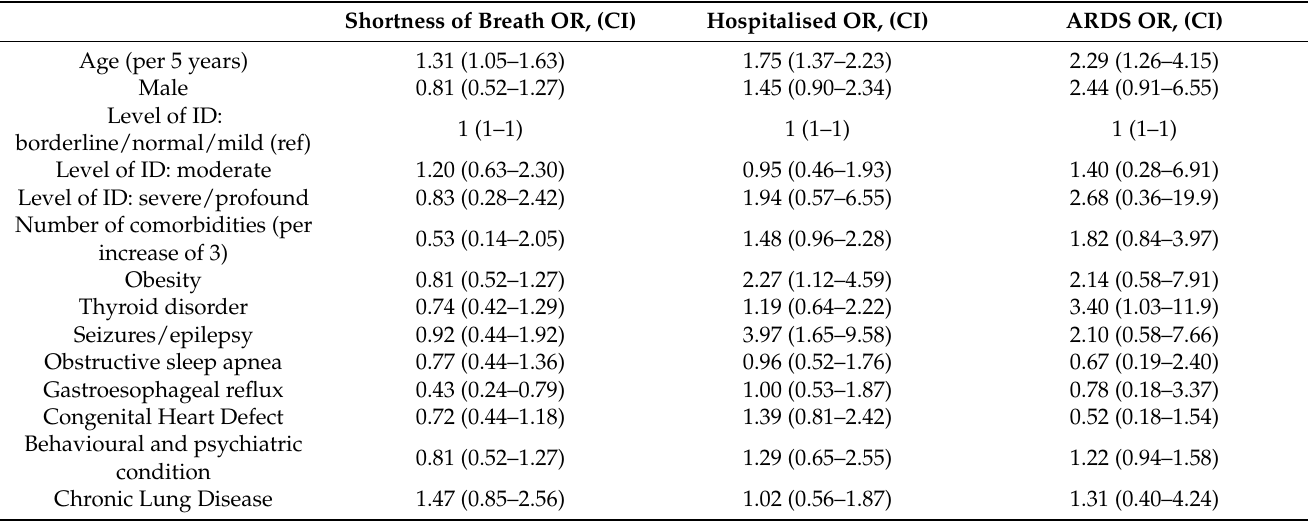
Table A8. Risk factors associated with adverse outcomes of COVID-19 in children with Down Syndrome. Associations with shortness of breath, hospitalisation, and acute respiratory distress. Patients with Down syndrome from the T21RS survey estimated in adjusted logistic regression models (odds ratios (OR) and 95% confidence intervals